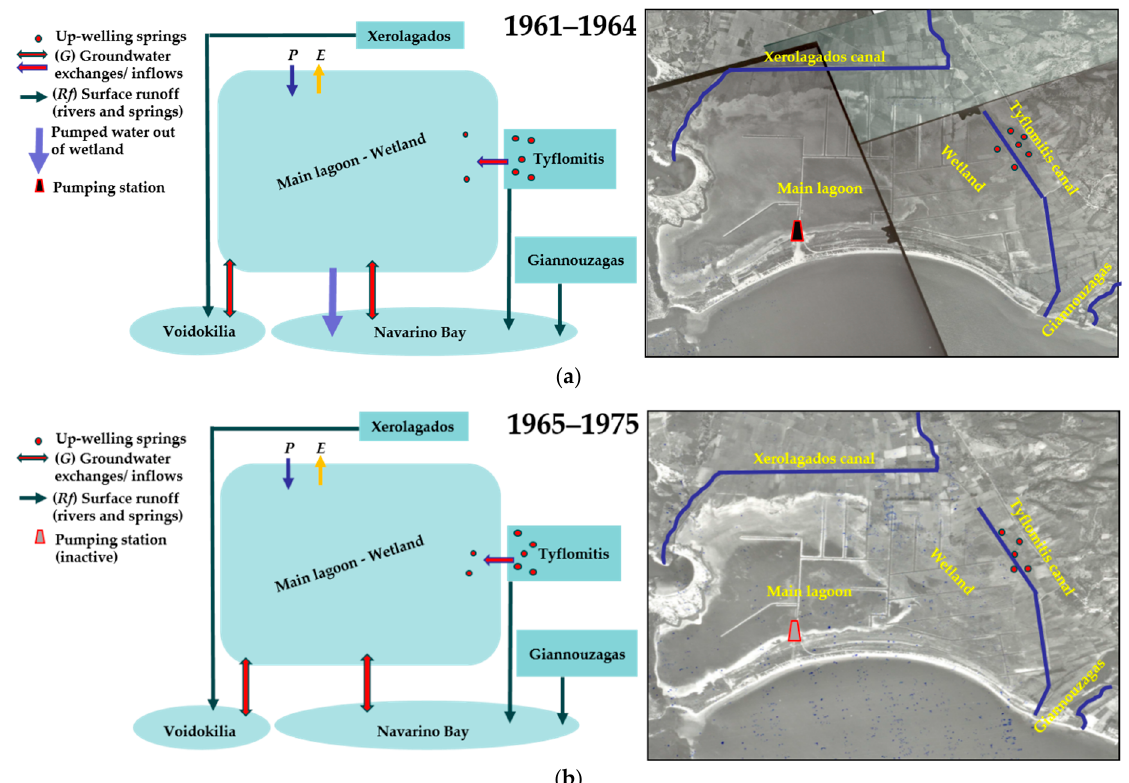
Figure 3. Schematic representation of the hydrologic conditions: ( a ) during the drainage period, based on a b/w aerial photograph from 1964, and ( b ) during the period 1965 – 1975, based on a b/w aerial photograph from 1972.